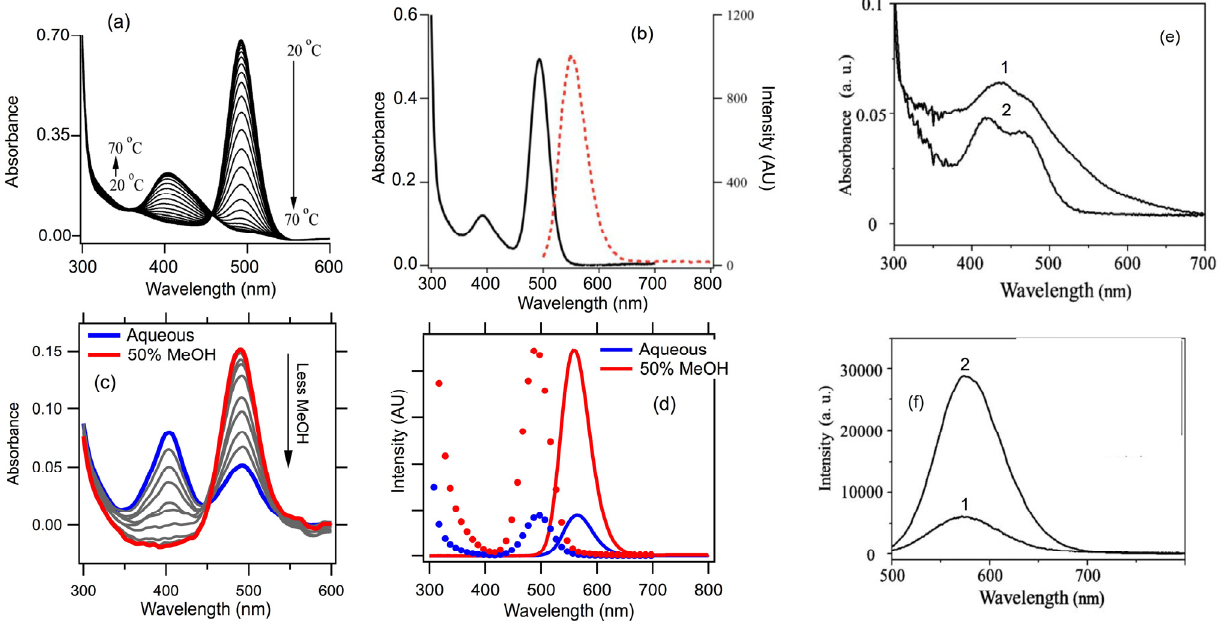
Figure 7. (Adapted with permission from [42,63,64]). ( a , b ) Hybridization -tuned equilibrium between dark and fluorescent forms of pure Ag N -DNA with 10–12 Ag atoms per DNA assembly. ( a ) Varying temperature, T , varies hybridization extent, producing an absorbance isosbestic point (~460 nm), that indicates an equilibrium between isomers. Peaks are at 400 nm (dark form) and 490 nm (fluorescent form) [63]; ( b ) Emission (red) and absorbance at intermediate T, with both cluster forms present. Excitation at 490 nm produces emission near 570 nm, but excitation near 400 nm produces no emission [63]; ( c , d ) Solvent -tuned equilibrium between dark and fluorescent forms of pure Ag 10 -DNA [41]; ( c ) Absorbance for MeOH fractions of 0% to 50% of the solvent, in 5% increments. The isosbestic point (near 450 nm) indicates equilibrium between two forms of the Ag 10 -DNA. Absorbance peaks at 400 nm (dark form) and 490 nm (fluorescent form) [42], just as for the hybridization-tuned equilibrium in ( a , b ); ( d ) Fluorescence excitation spectra (dotted) and emission spectra at 0% and 50% MeOH. The increase in intensity is due to the higher fraction of the fluorescent form [42]; ( e , f ) Studies of Ag-DNA and Ag-Cu-DNA made by reducing Cu 2+ on the fluorescent Ag-DNA solution [64]; ( e ) Absorbance of unpurified solutions shows two peaks at similar wavelengths for Ag-DNA (1) and Ag-Cu-DNA (2), close to those for the dark and fluorescent cluster forms of pure Ag N -DNA in ( a ) and ( c ). The poorly resolved peak structure in the unpurified solutions in ( e ) indicate the presence of additional cluster species. ( f ) Emission from the unpurified Ag-DNA solution (1) increased upon reduction of Cu 2+ (2). The 560 nm emission lies near the 560–570 nm emission peaks in the pure Ag N -DNAs in ( a – d ), suggesting that Cu 2+ may also be controlling an equilibrium between dark and fluorescent cluster